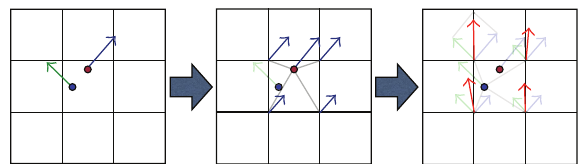
Figure 5: Geometrical conversion based on a splatting function with zero velocity field v (13). The method served as a bridge to transform the computation from an irregular grid to a regular grid which allows an e ffi cient parallel